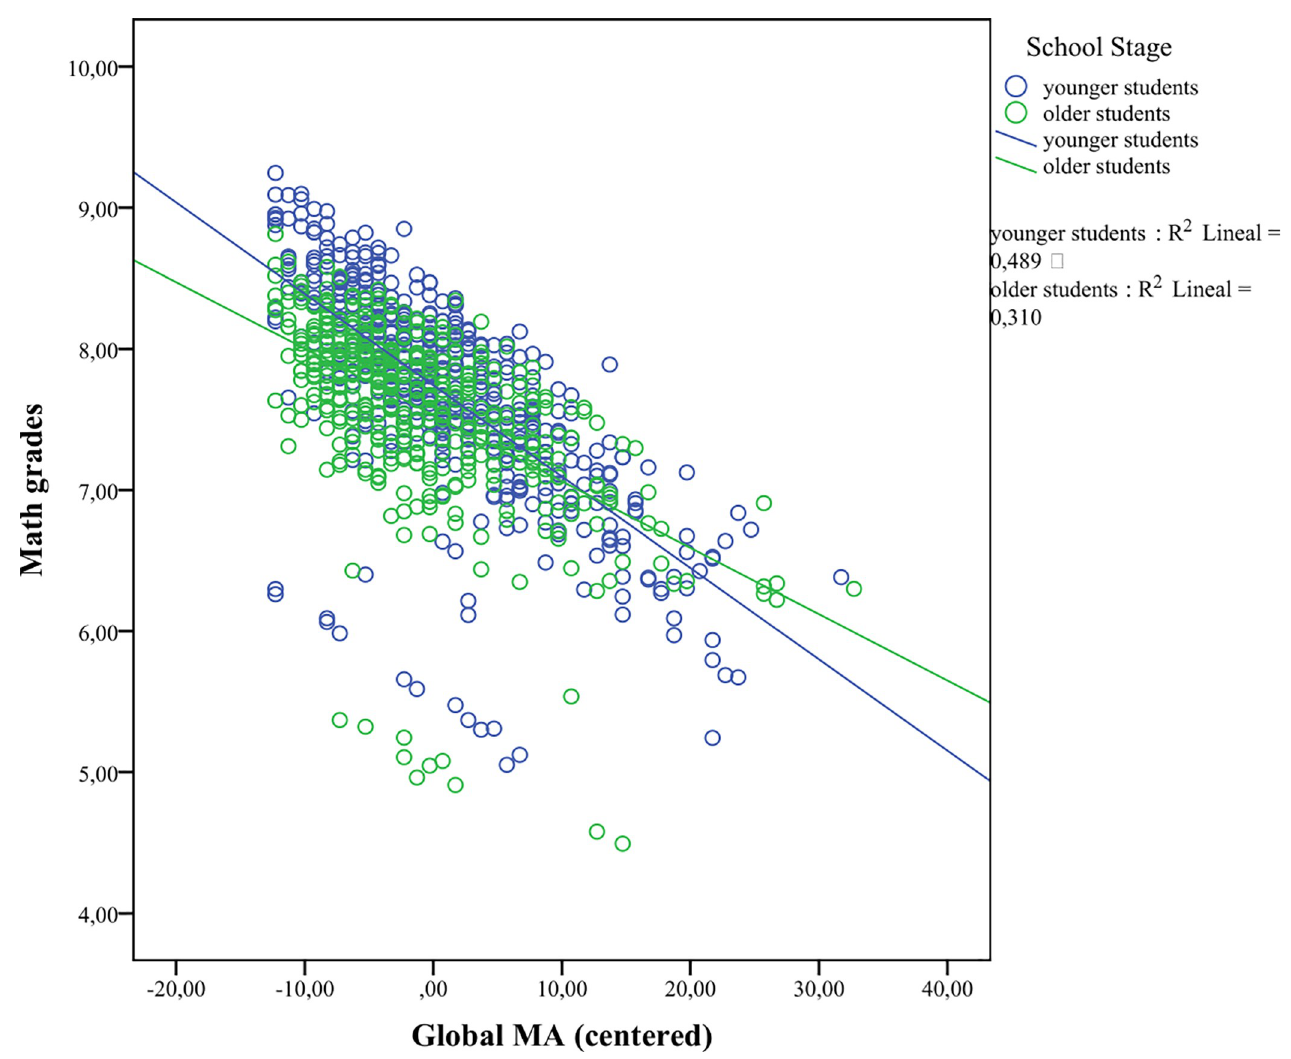
Fig 1. Interaction term between school stage and MA (as a centered variable) in predicting math